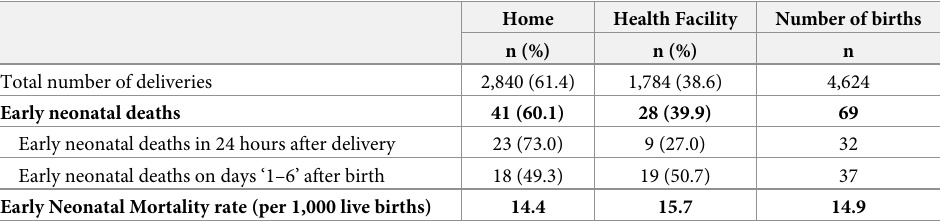
Table 2. Early neonatal outcomes (in the three years preceding the survey) by place of delivery, Bangladesh DHS